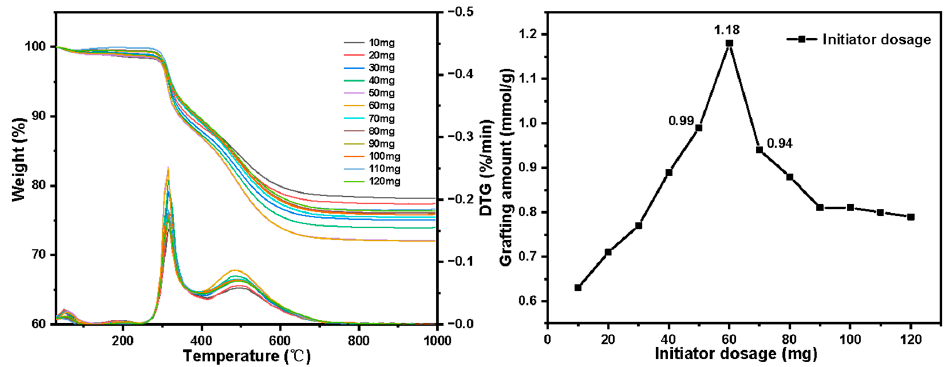
Figure 13. Grafting amount varies with initiator dosage.